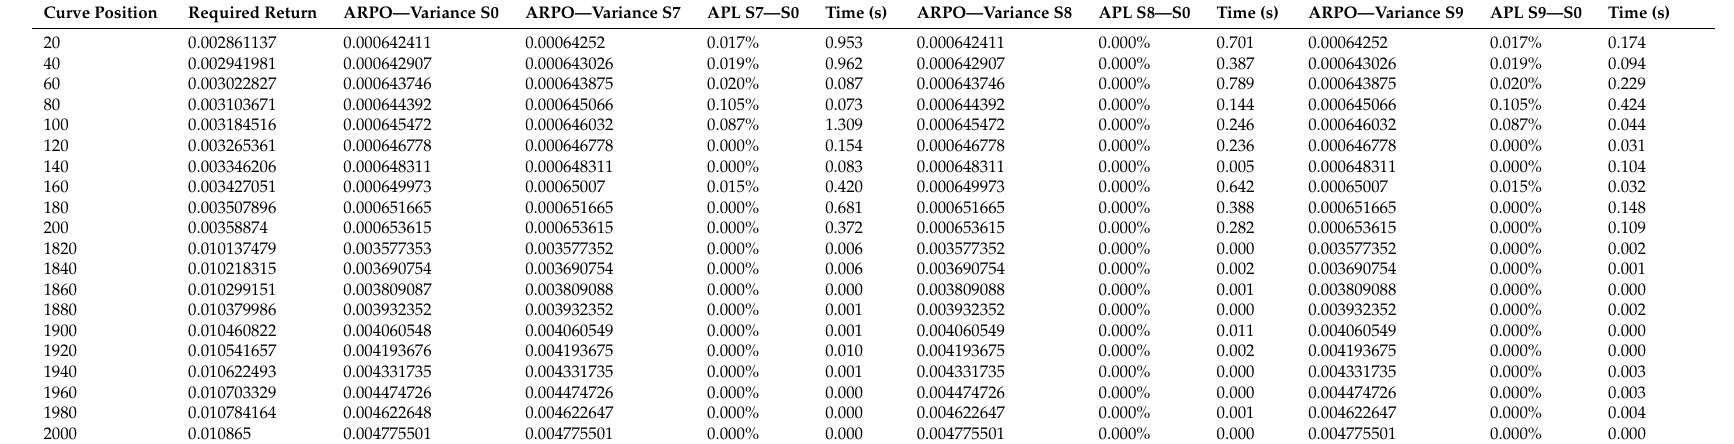
Table 10. Comparison of results for different scenarios based on Instance 1 (Hang Seng) varying problem quantity constraints. Curve